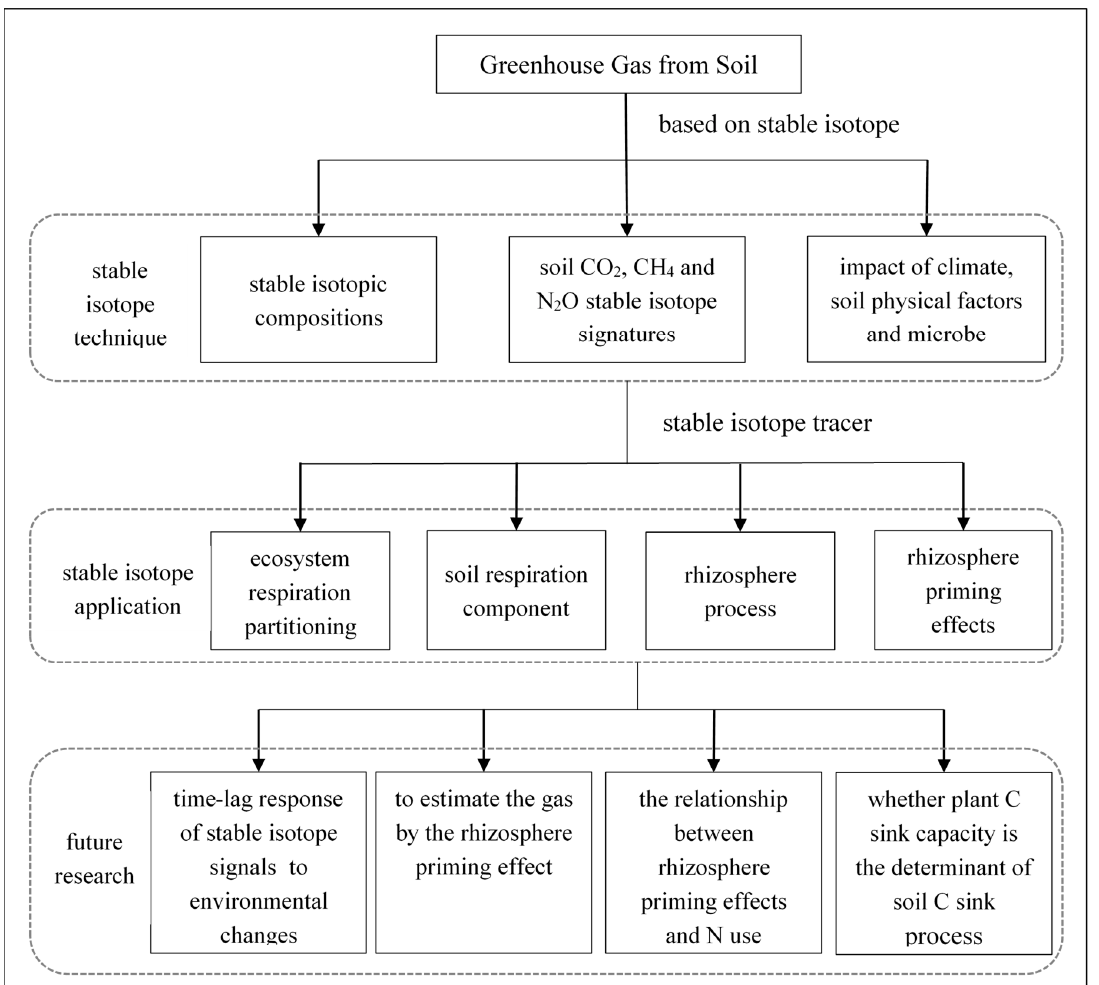
Figure 3 . Overview of processes determining the stable isotope signals of greenhouse gas from soil.